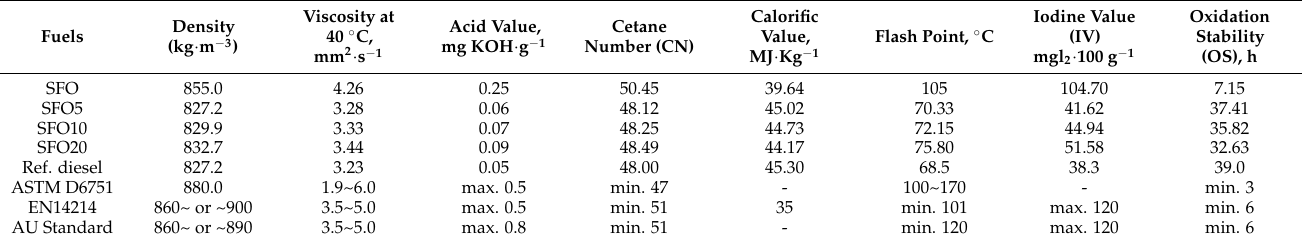
Table 4. Fuel properties of SFO biodiesel blends compared with international